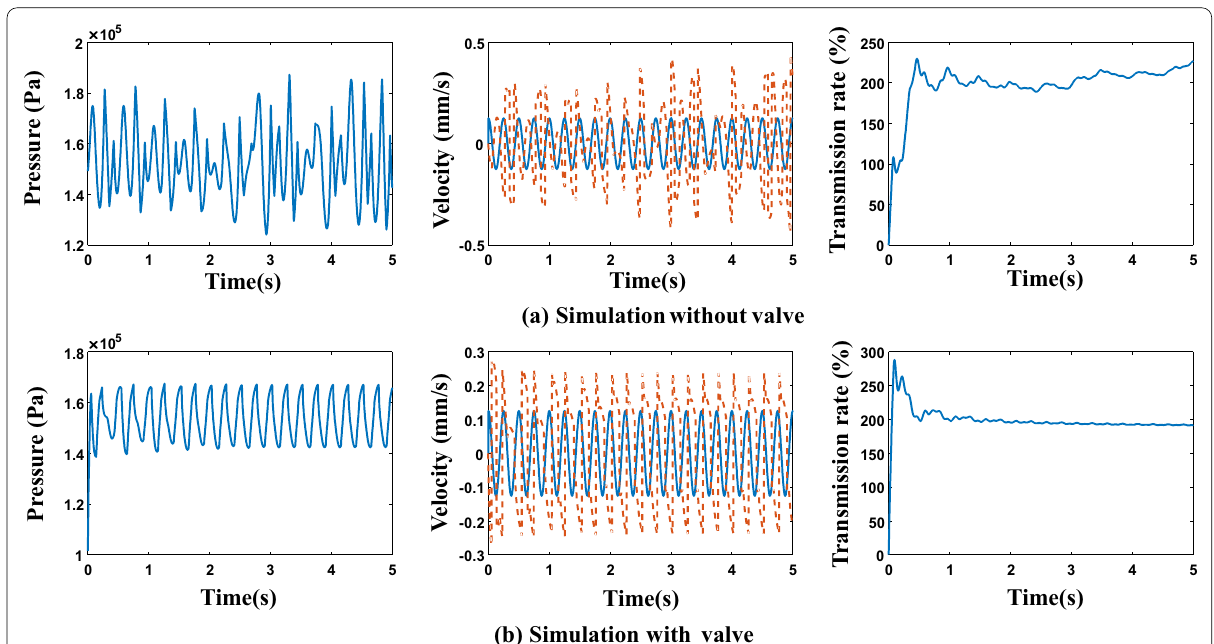
Figure 7 Simulation results comparison of pressure, velocity and transmission rate under 4 Hz vibration